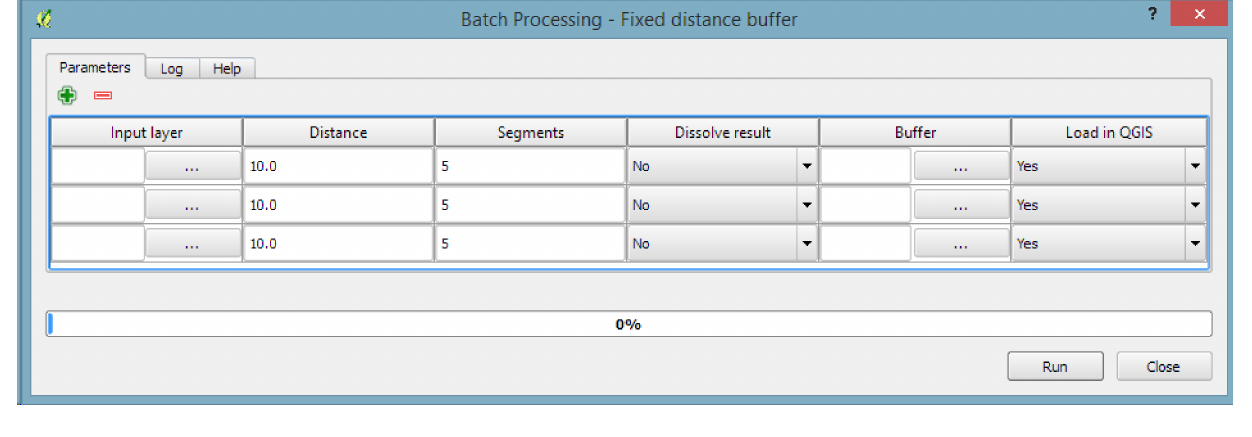
Figure 6. Processing Batch processing GUI.